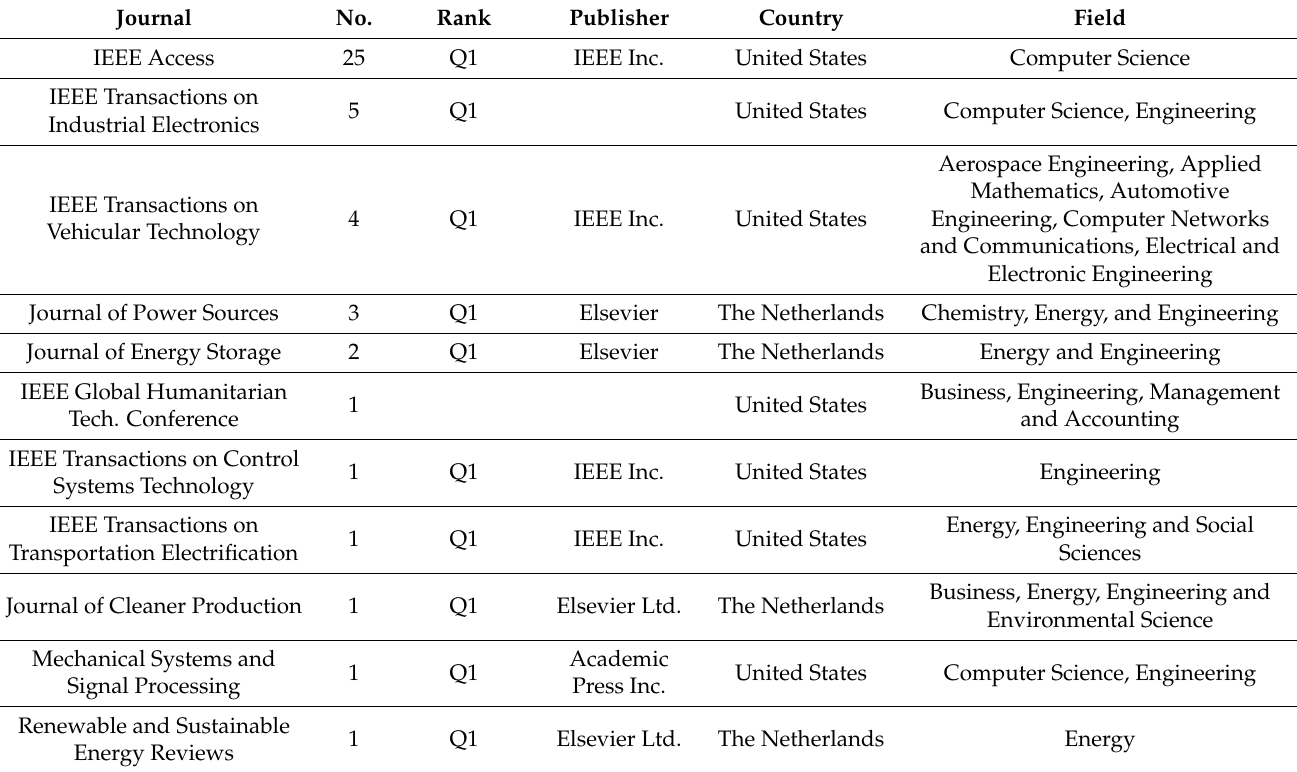
Table 3. Description of literature